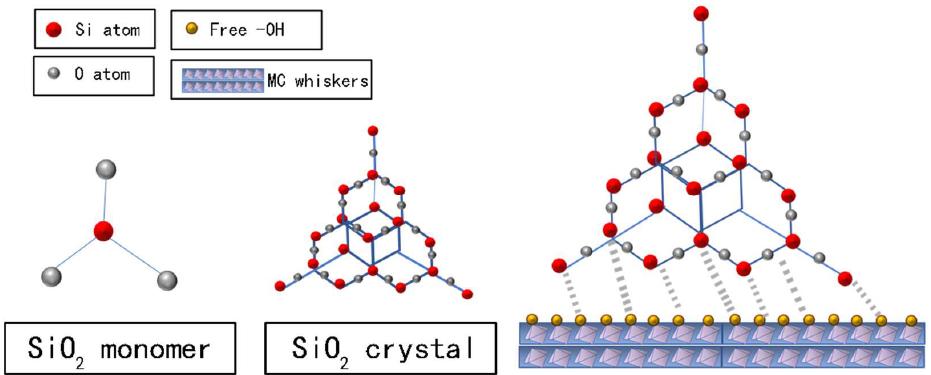
Figure 9. Model of chemical reaction of MOA and FA.